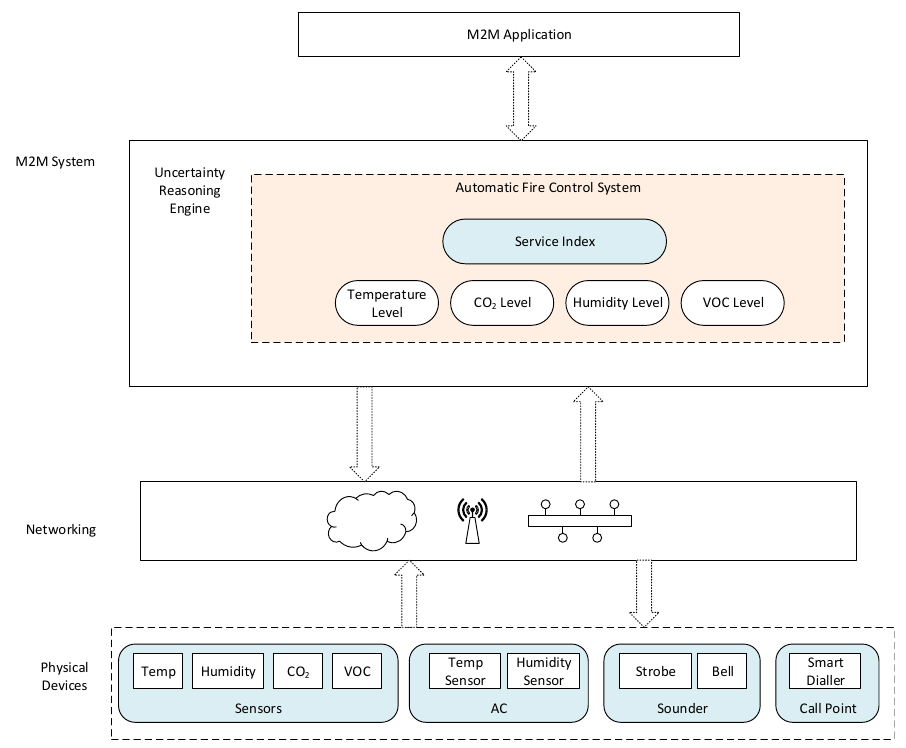
Figure 7. Use case of an automatic fire control